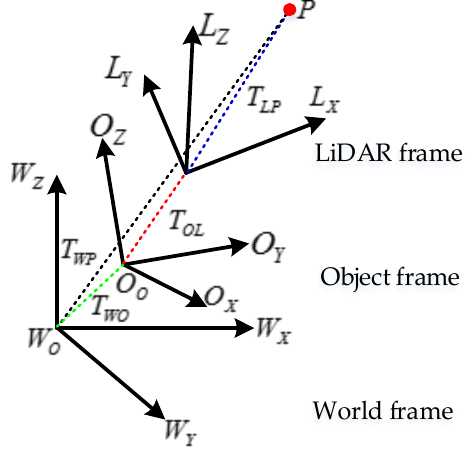
Figure 3. The LiDAR, Object and World frames as well as the feature point P .